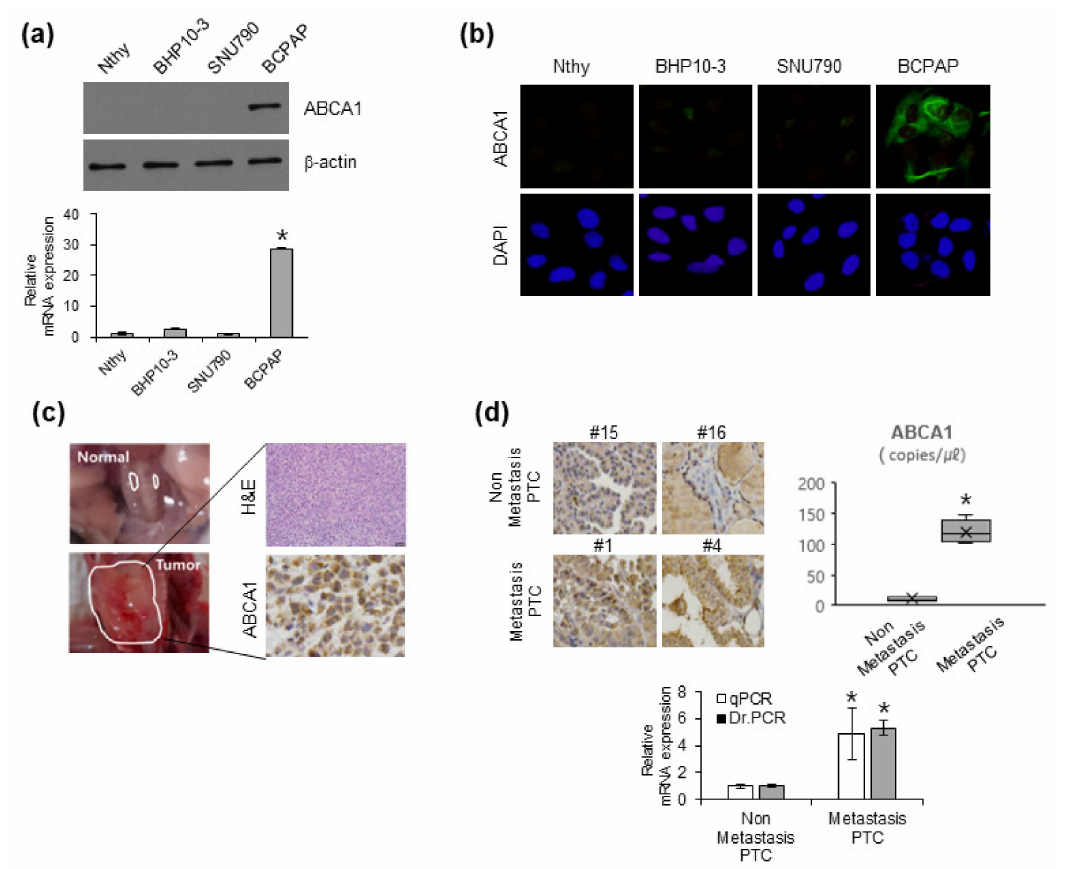
Figure 2. ABCA1 expression in papillary thyroid cancer cells and patients suffering from cancer with lung metastasis. ( a , b ) Expression levels of ABCA1 in Nthy immortalized non-cancer cells and three thyroid cancer cell lines were analyzed via Western blotting, qRT-PCR, and immunocytochemistry. DAPI was used to stain the nuclei of cells. ( c ) Representative H&E and ABCA1-stained tumor tissues from mice injected with BCPAP cells. Scale bar: 100 µ m. Data are presented as the mean ± SEM (n = 4, independent experiments). ( d ) Representative IHC images showing ABCA1 levels in a sample from a patient with thyroid cancer with lung metastasis (upper left). Scale bar: 100 µ m. Differences in the expression levels of ABCA1 in FFPE of patients with thyroid cancer with or without lung metastases were analyzed via qRT-PCR (lower) and Dr. PCR (upper right and lower). * p < 0.05 (Fisher’s exact